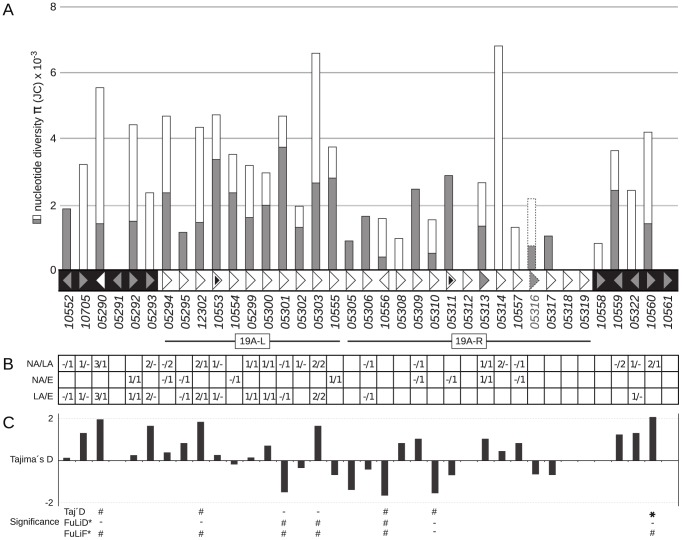
Cluster 19A nucleotide diversity π, fixed polymorphisms and neutrality tests.(A) Genes are illustrated in the genomic gene order. Arrowheads below the graph indicate their reading direction. White and grey arrows depict secreted and non-secreted protein-coding genes, respectively. Black sections are cluster-flanking regions. Black triangles highlight genes that revealed truncated alleles. Numbers correspond to U. maydis gene numbers in (MUMDB). Two-section columns height corresponds to nucleotide diversity π with Jukes-Cantor (JC) correction (scaled on left axis) and its sections reflect the ratio of non-synonymous (grey) and synonymous (white) substitutions. The pseudogene um05316 is dotted. (B) Number of fixed polymorphisms between subpopulations of North America (NA), Europe (E) and Latin America (LA). First and second numbers refer to non-synonymous and synonymous substitutions, respectively. (C) Tajima's D statistics for gene datasets of cluster 19A. P-values of Tajima's D (Taj'D) and corresponding Fu & Li's D* (FuLiD) and F* (FuLiF) statistics are highlighted with # (p<0.05) and * (p<0.01).